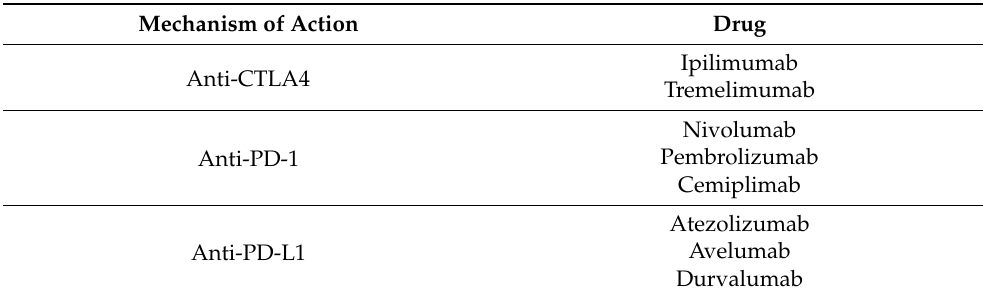
Table 1. List of available immune checkpoint inhibitors licensed by the